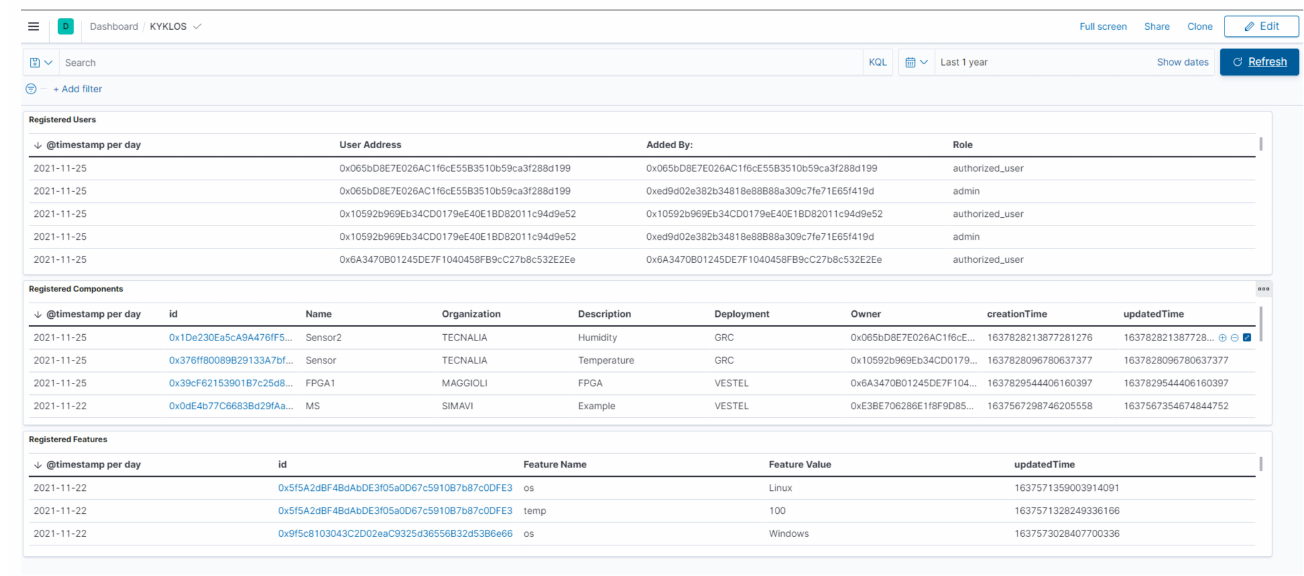
Figure 4. Example of a graphical monitor client (general dashboard from KYKLOS 4.0